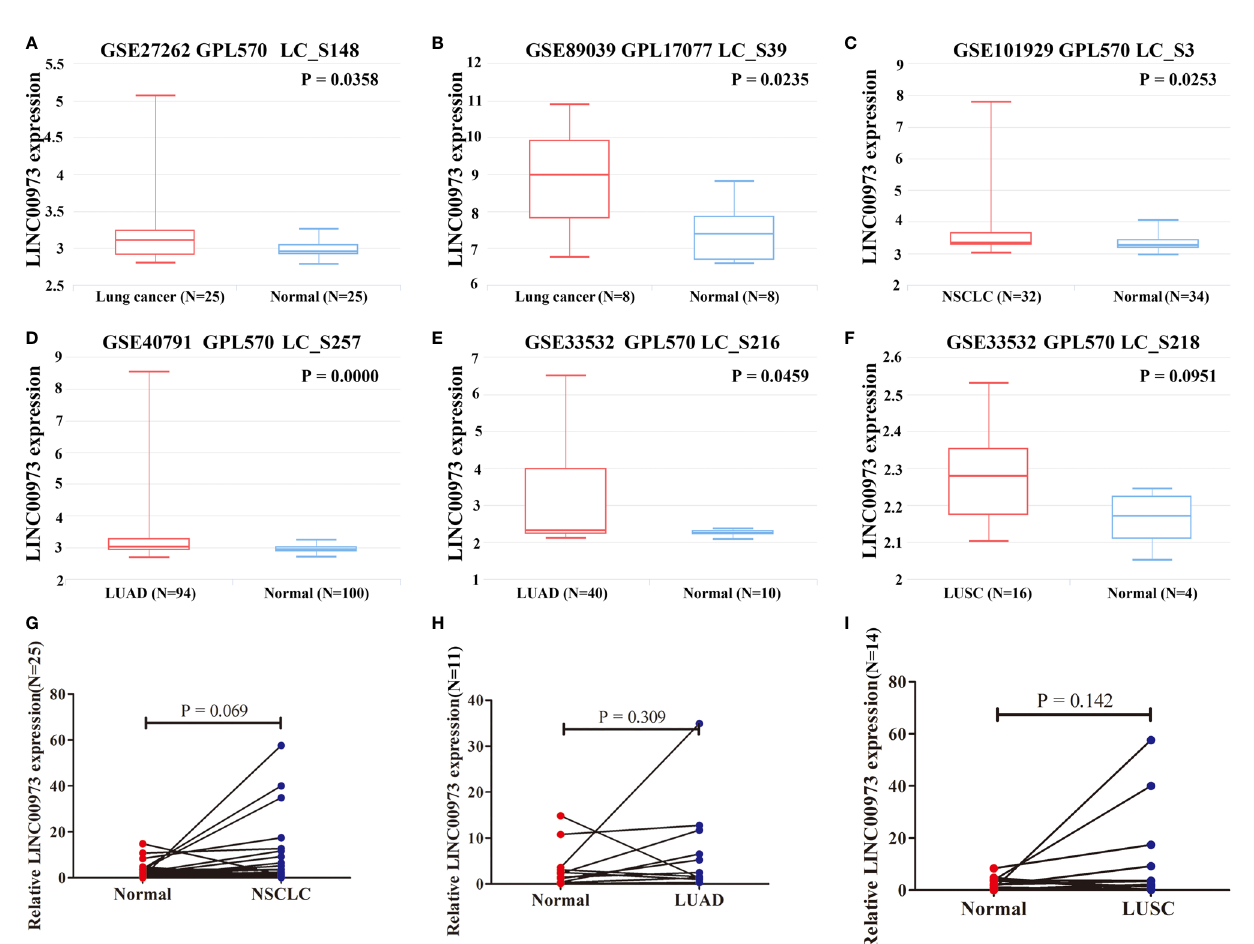
FIGURE 2 | LINC00973 expression was upregulated in the LNCAR database and clinical NSCLC tissues. (A) GSE27262 (LC_S148); (B) GSE89039 (LC_S39); (C) GSE101929 (LC_S3); (D) GSE40791 (LC_S257); (E) GSE33532 (LC_S216); (F) GSE33532 (LC_S218); (G) Clinical NSCLC samples; (H) Clinical LUSD samples; (I) Clinical LUSCsamples. NSCLC, Non-small cell lung cancer; LUAD, lung adenocarcinoma; LUSC, lung squamous cell carcinoma; Normal, normal